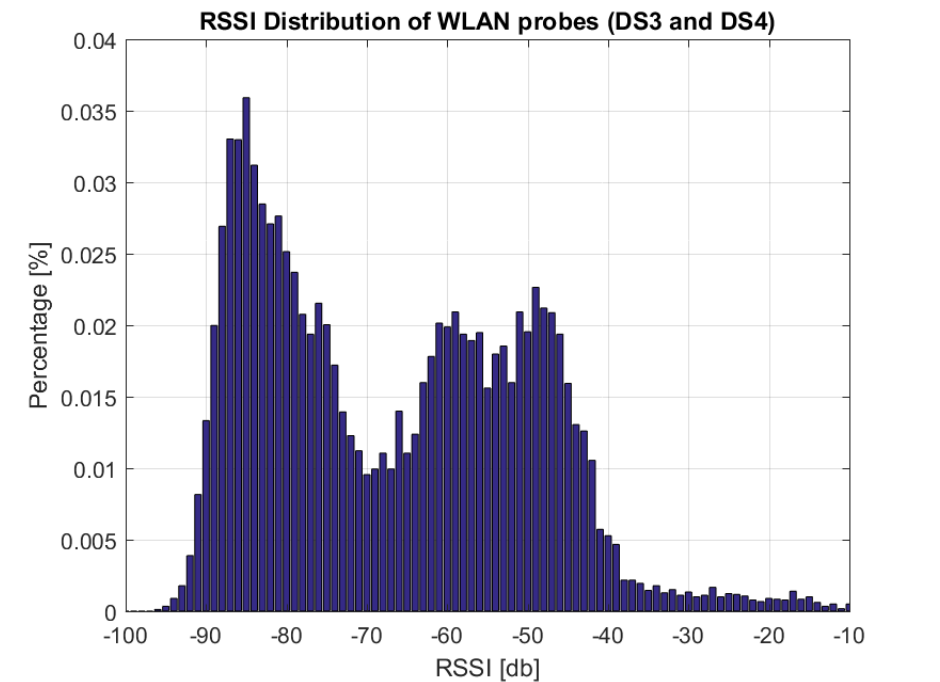
Figure 4. Distributionof registered RSSI values of collected WLAN probes in datasets 3 and 4 (DS3 and DS4) (bin size 1